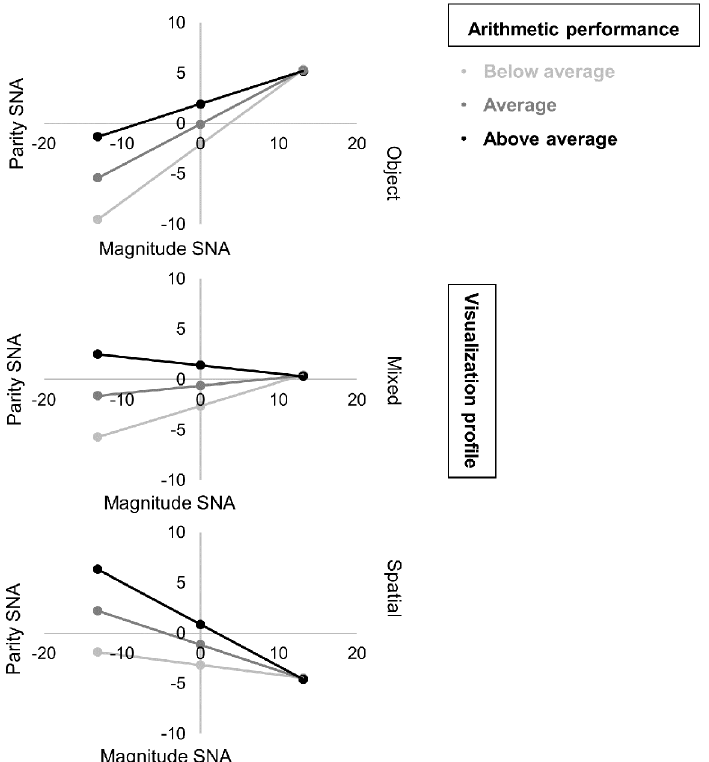
Figure 4. The relationship between parity and magnitude SNARC regression slopes at the means and at one standard deviation below and above the means of arithmetic performance and visualization